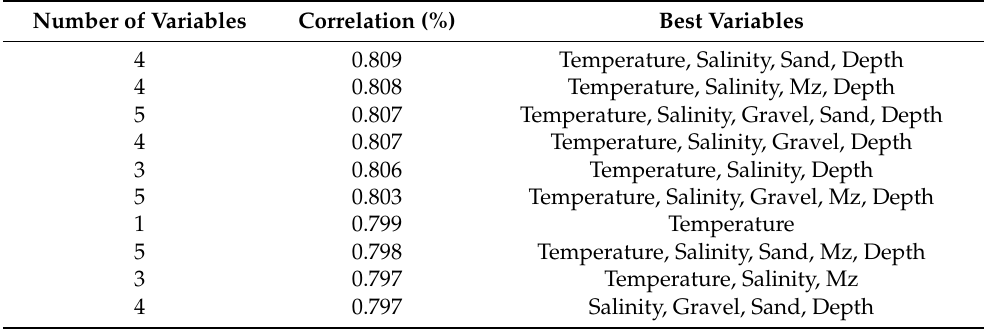
Table 5. Environmental and biological variables affecting the macrobenthos community as deter- mined by a biota–environment matching (BIO–ENV) analysis (Mz = mean grain size).